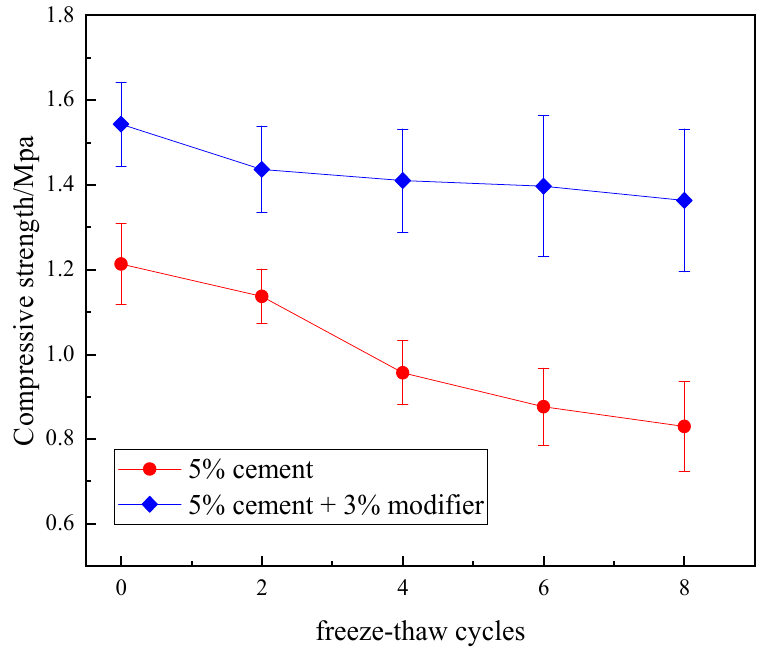
Figure 7. Influence curves of curing time on compressive strength.